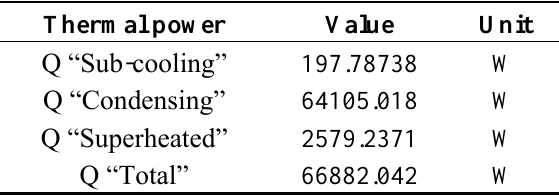
Table 14. Thermal power exchanged.